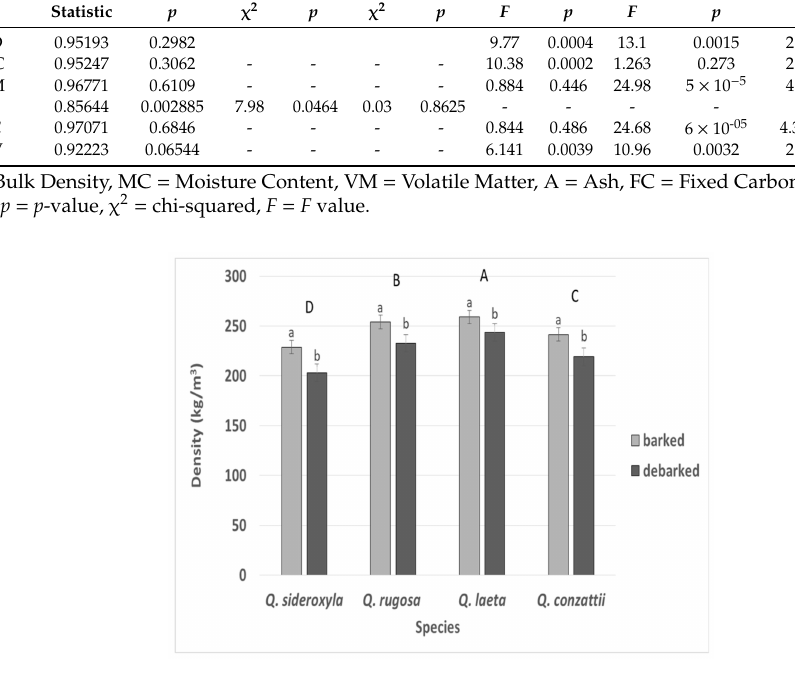
Figure 2. Sawdust bulk density of four barked and debarked oak species. (bars with di ff erent letters correspond to statistically di ff erent densities; p <